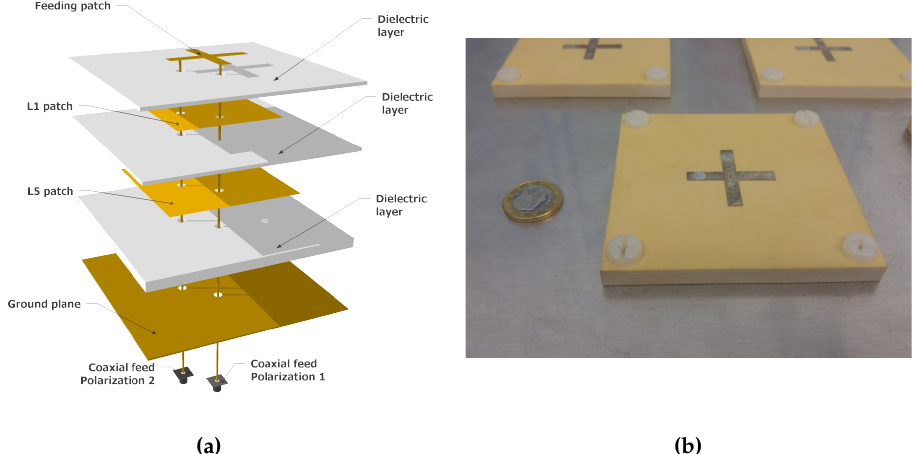
Figure 2. 3D model of the antenna elements ( a ), and photography of one of the manufactured antennas ( b ). The antenna measures 95 × 95 × 8